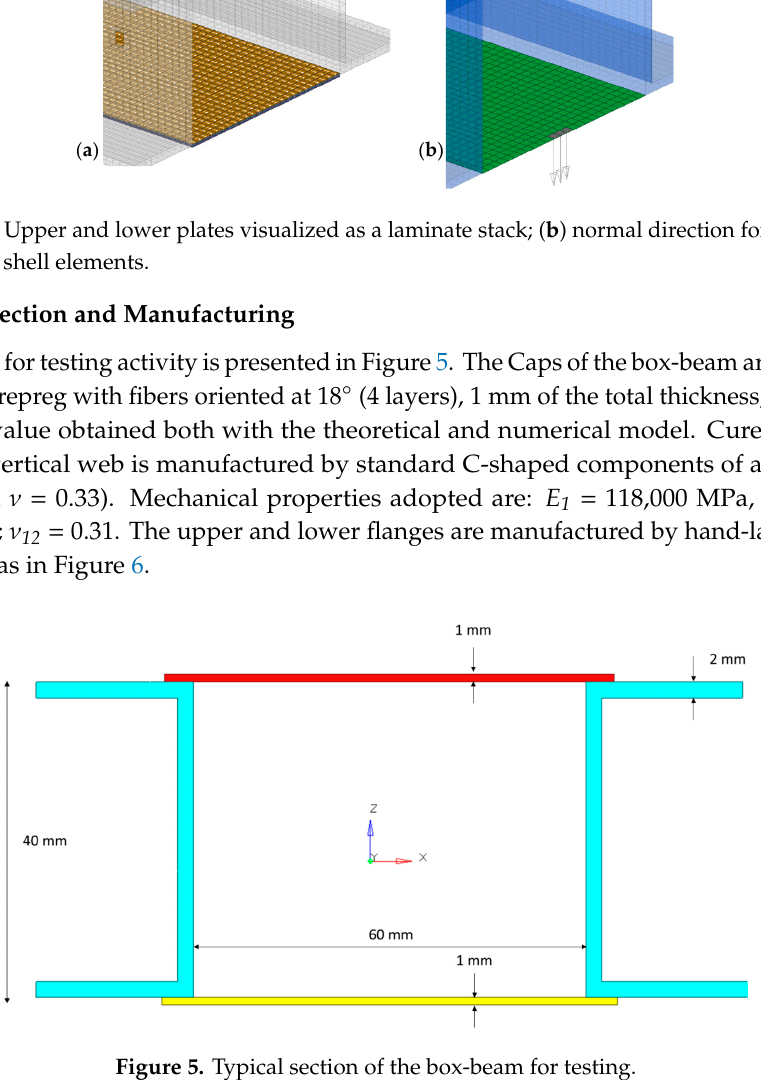
Figure 5. Typical section of the box-beam for testing.